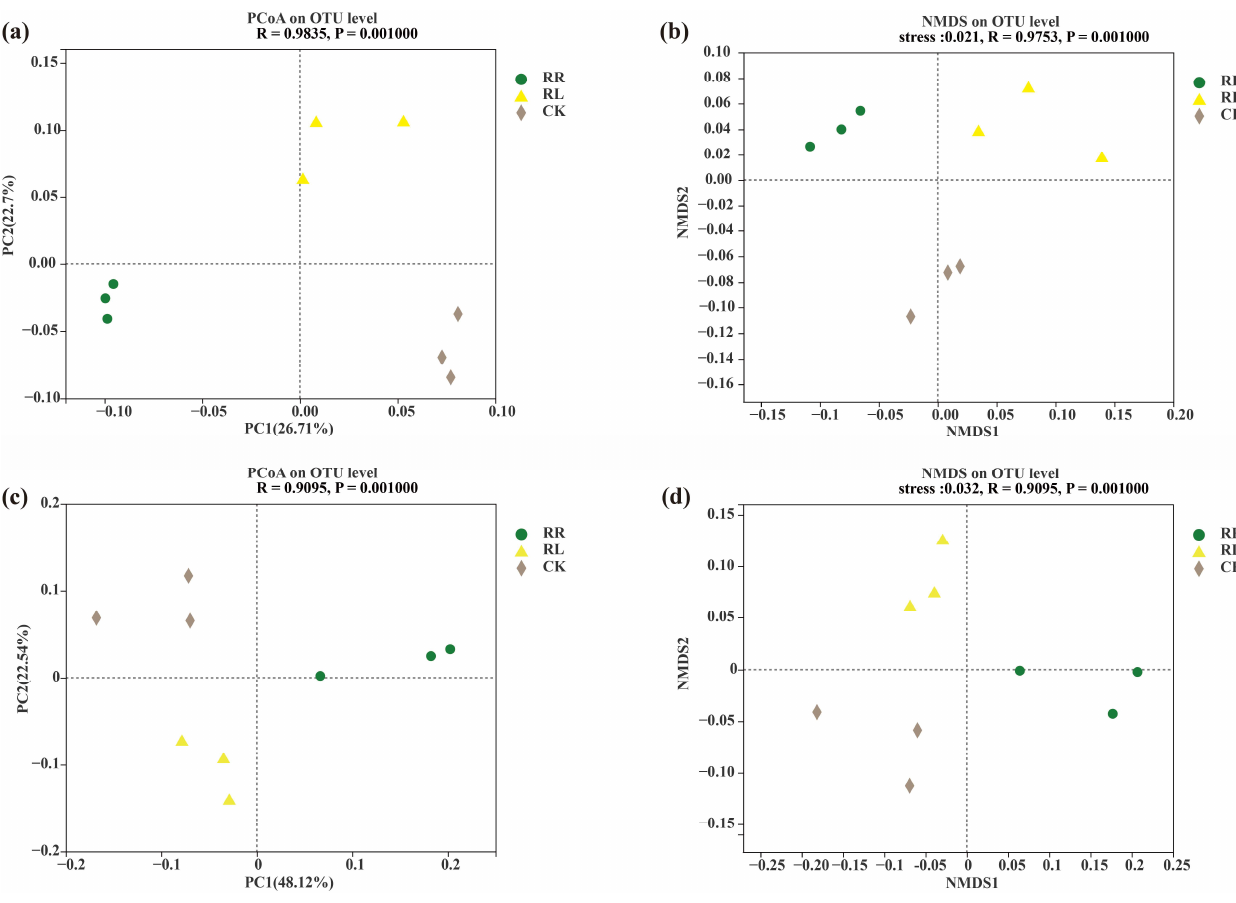
Figure 2. Comparison of soil microorganisms in rhizospheres of oilseed rapes in the monoculture (RR), intercropping system (RL) and background (CK); ( a ) PCoA of soil bacterial communities at the OTU level; ( b ) NMDS of soil bacterial communities at the OTU level. ( c ) PCoA of soil fungal communities at the OTU level; ( d ) NMDS of soil fungal communities at the OTU level. As shown in Figure 3a, there were 10, 9 and 9 dominant soil bacterial phyla (i.e., In addition, Ascomycota, unclassified_k__Fungi, Chytridiomycota, Mortierellomycota relative abundances were greater than 1%) in the monoculture system (RR), intercropping and Basidiomycota were the dominant soil fungal phyla (i.e., relative abundances were system (RL) and control (CK), respectively. greater than 1%) in the RR, RL and CK (Figure